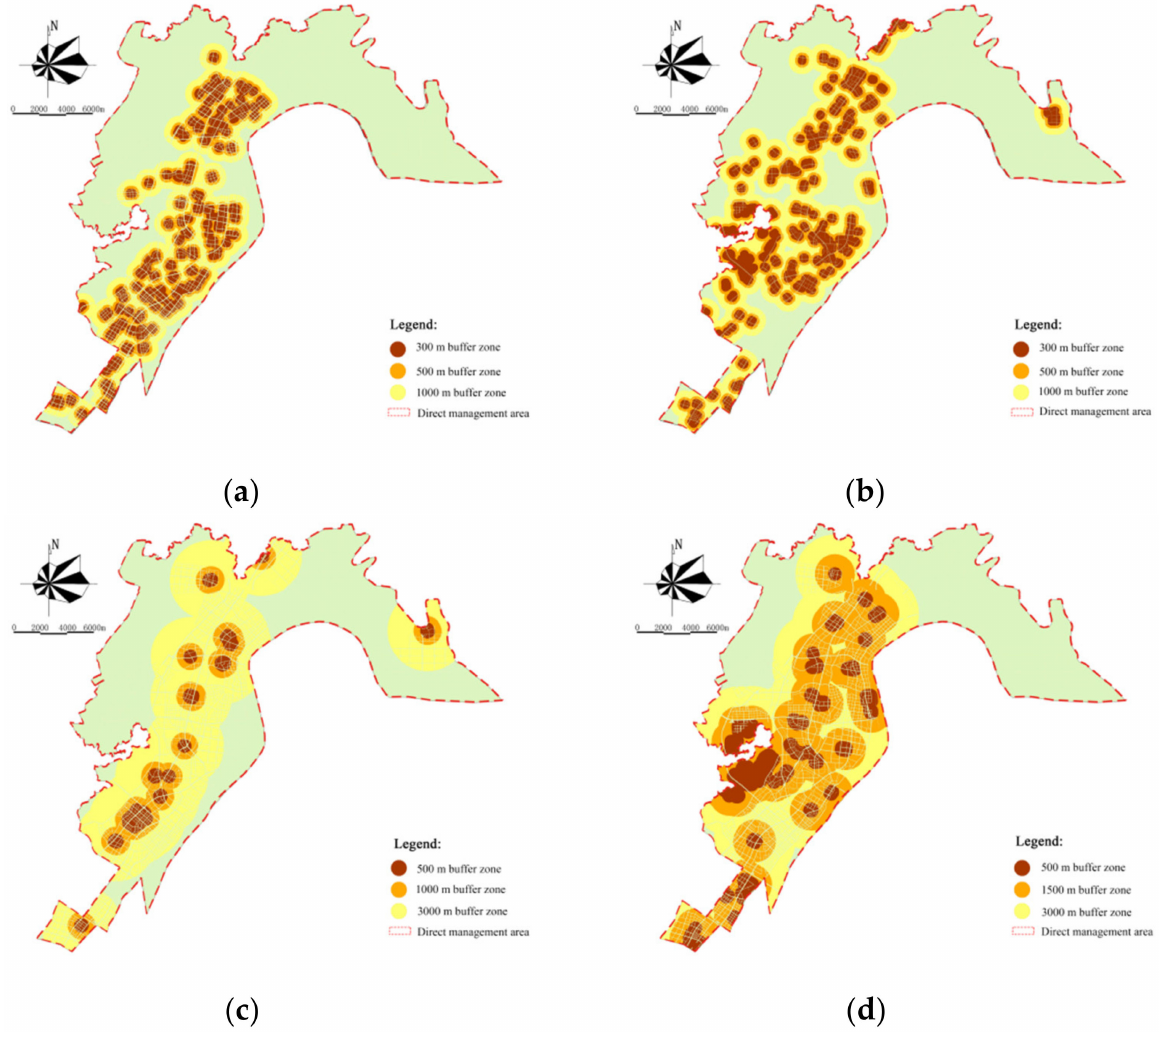
Figure 6. ( a ) Multi-ring buffer zone analysis of educational facility; ( b ) Multi-ring buffer zone analysis of commercial service facility; ( c ) Multi-ring buffer zone analysis of medical facility; ( d ) Multi-ring buffer zone analysis of cultural and sports